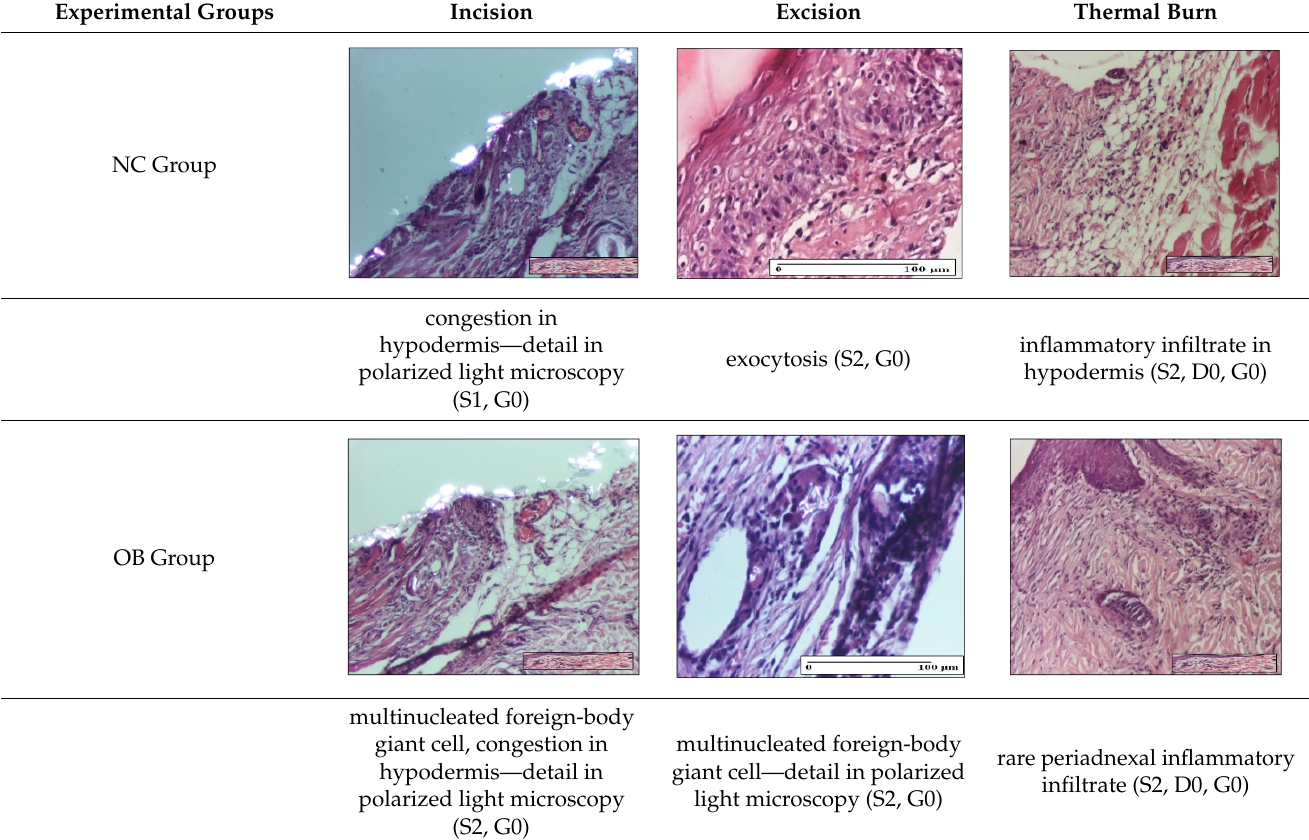
Table 5. Histopathological evaluation of the tissue samples on day 12.